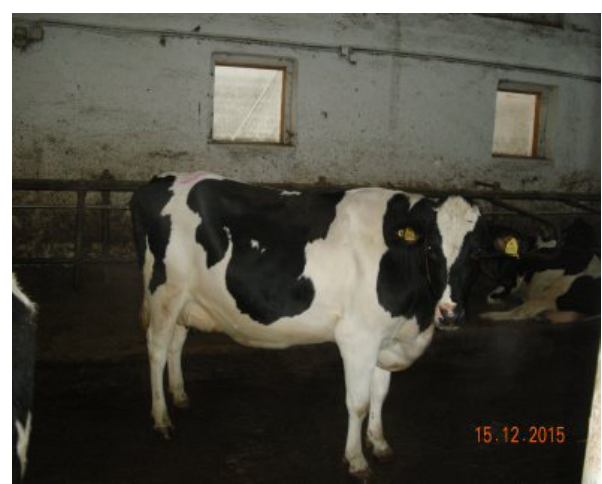
Figure 6. A clean cow standing on separated